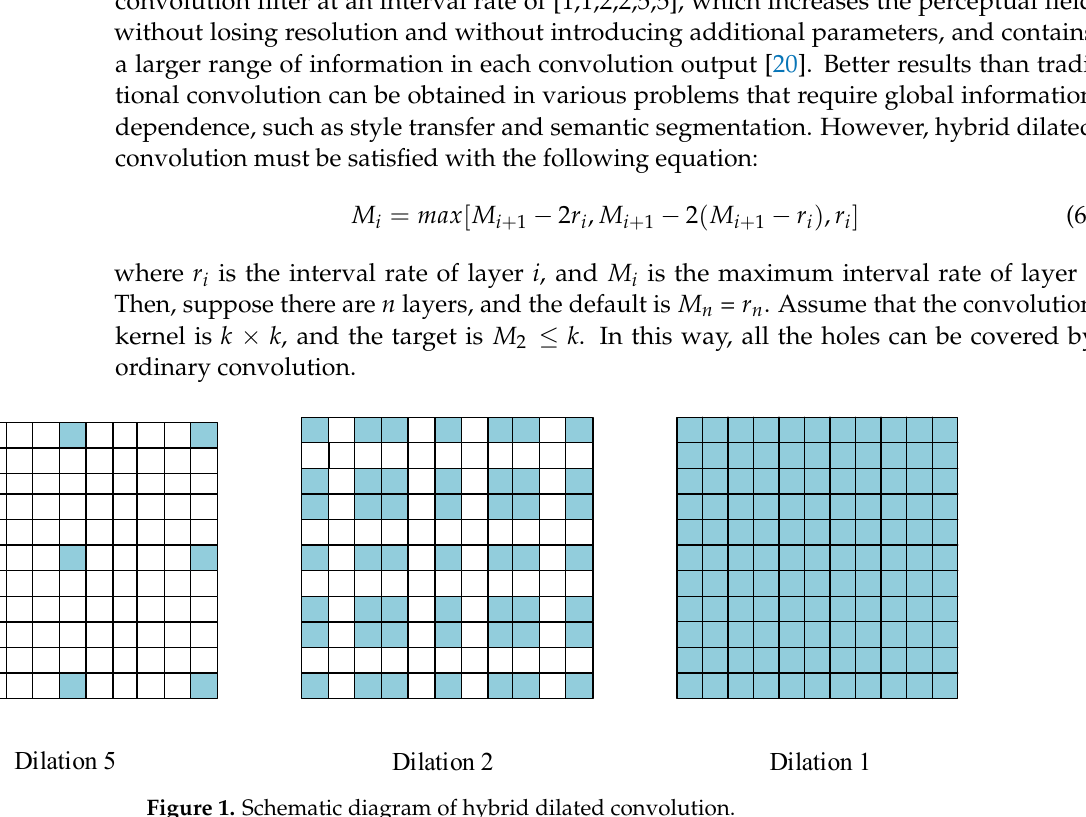
Figure 1. Schematic diagram of hybrid dilated convolution.